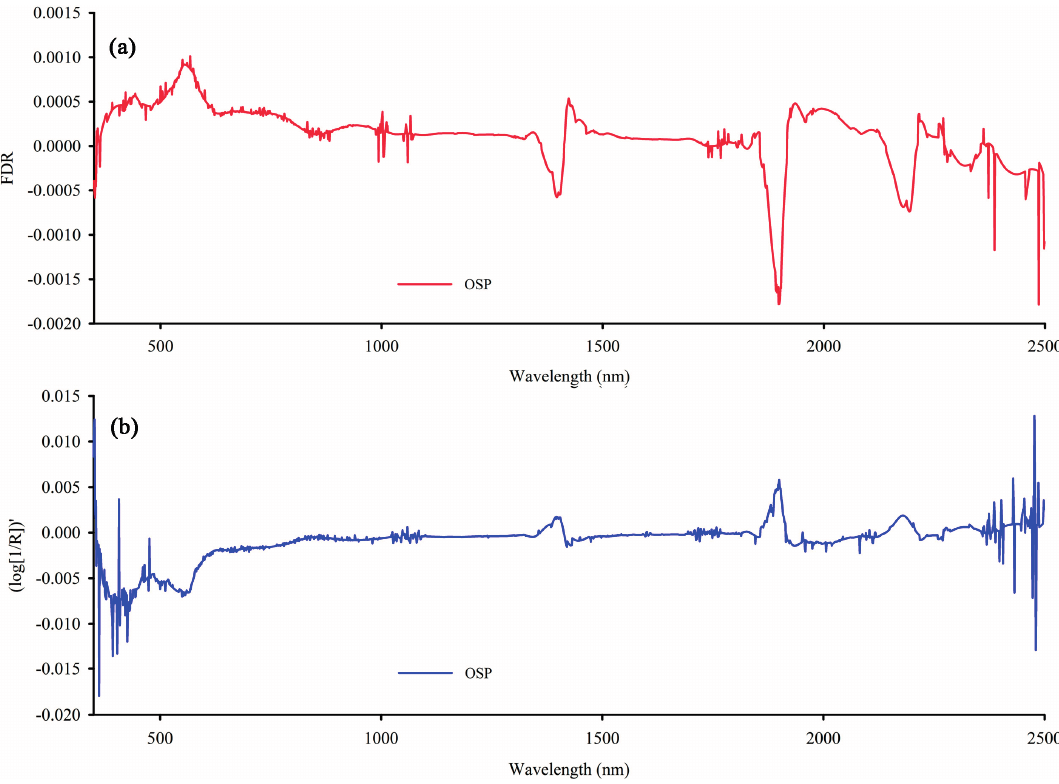
Figure 8. Optimal spectrum (OSP) of the first derivative differential (FDR) ( a ) and the first derivative differential of reciprocal logarithm (log[1/R]) ′ ( b